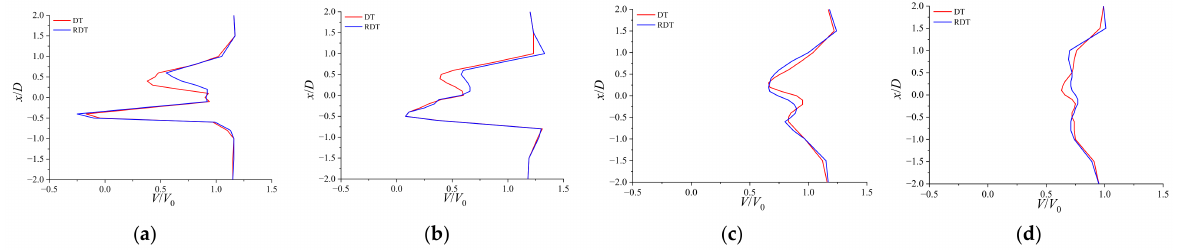
Figure 21. Profiles of mean streamwise velocity for γ = 60 ◦ at different streamwise locations in the central x - z plane: ( a ) z / D = 0.5; ( b ) z / D = 1.0; ( c ) z / D = 3.0; ( d ) z / D = 5.0.